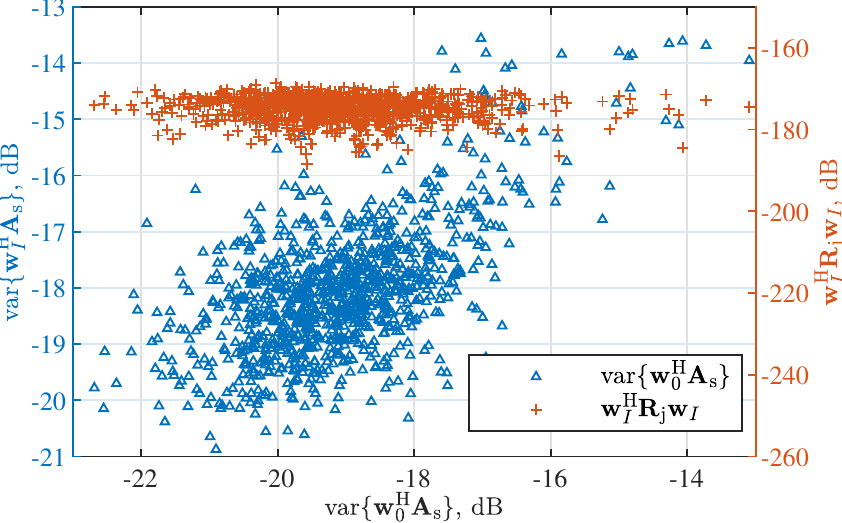
Figure 4. The impact of the initialization on the convergence performance, where the left axis observes the beam flatness and the right one observes the converging value of the objective function in